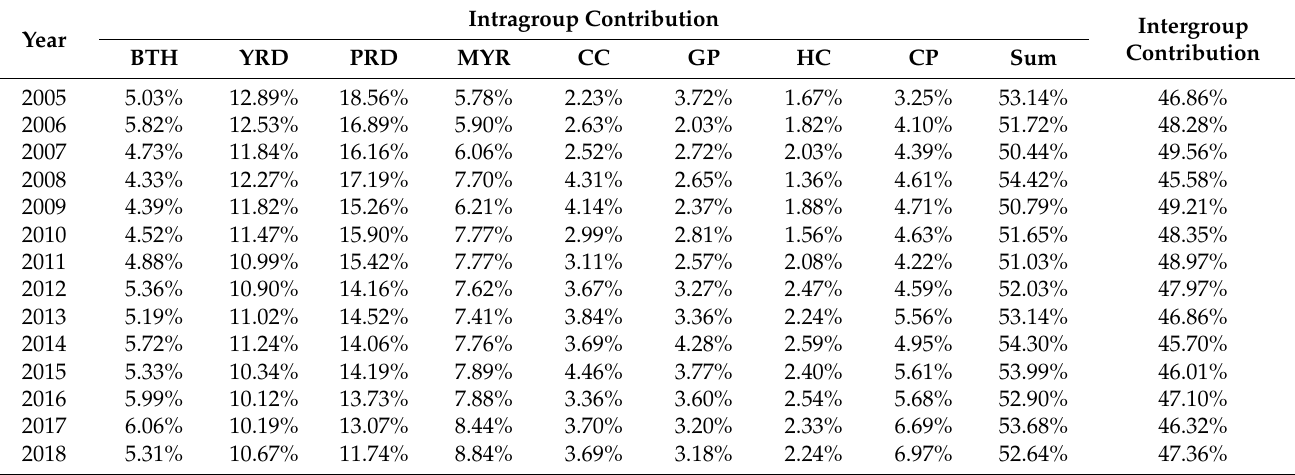
Table 4. The spatial source contribution of the overall resilience difference among the eight urban agglomerations.